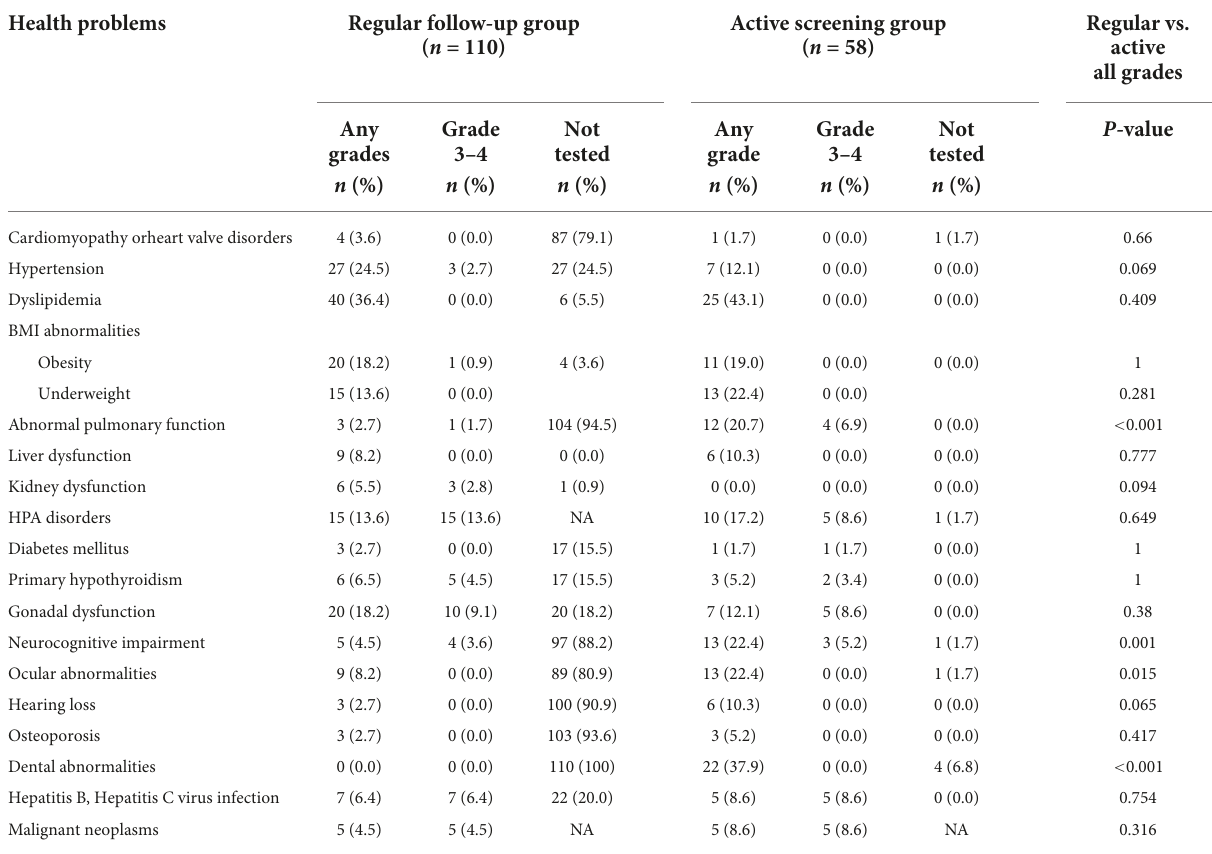
TABLE 4 Prevalence of health problems in CCSs in regular follow-ups and active screening. Health problems Regular follow-up group